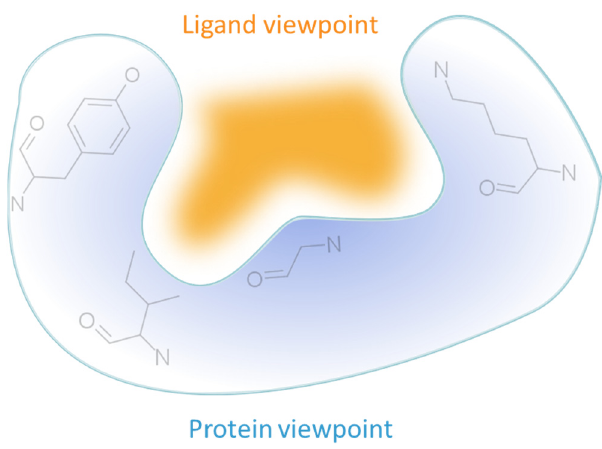
Figure 3. Protein cavity representation according to the protein or the ligand perspective.